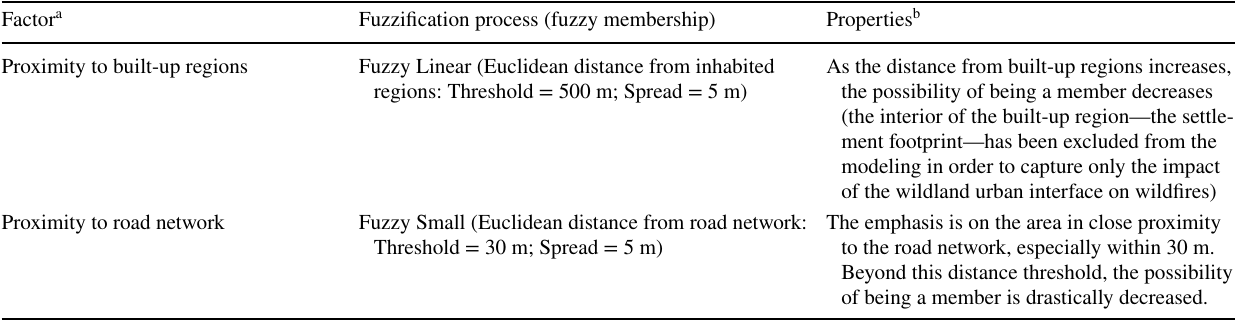
Table 2 Fuzzy logic modeling weighting scheme for the proximity of residential and road network entities to forested areas in the Chalkidiki study